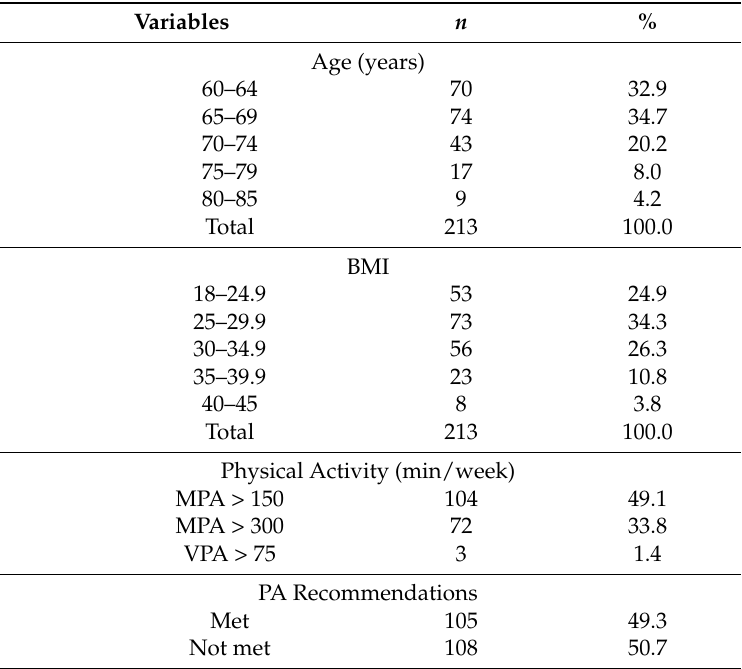
Table 1. Participant